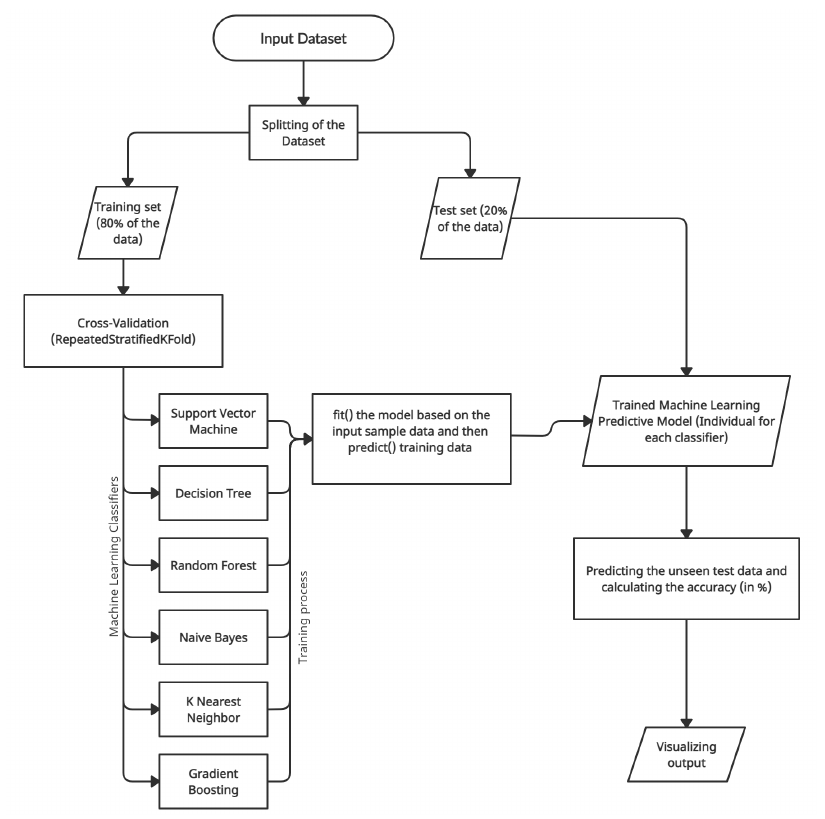
Figure 6. Machine-learning-model building schematic